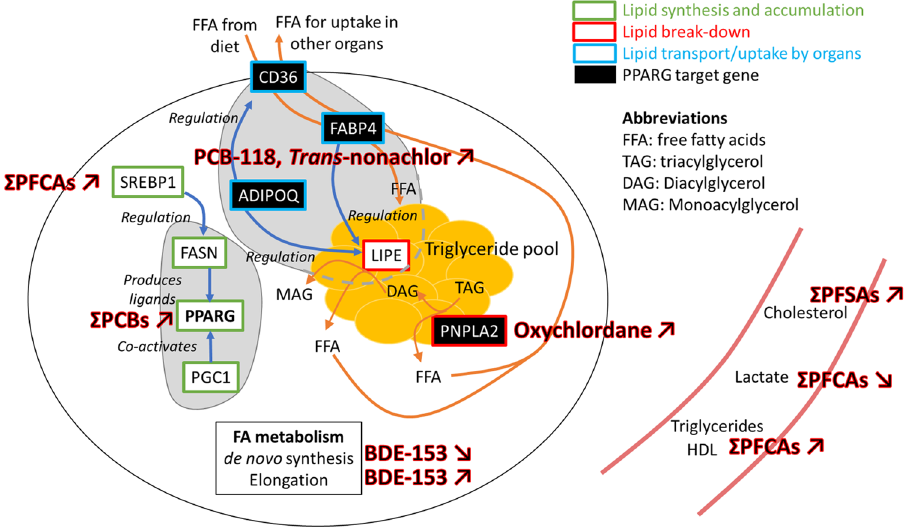
Figure 3. Schematized functions of the genes of interest and summary of the relationships between pollutants and biomarkers of energy metabolism in ( A ) a white adipocyte and ( B ) plasma. For a detailed description of lipid metabolism in white adipocyte see Sethi and Vidal-Puig (2007) 106